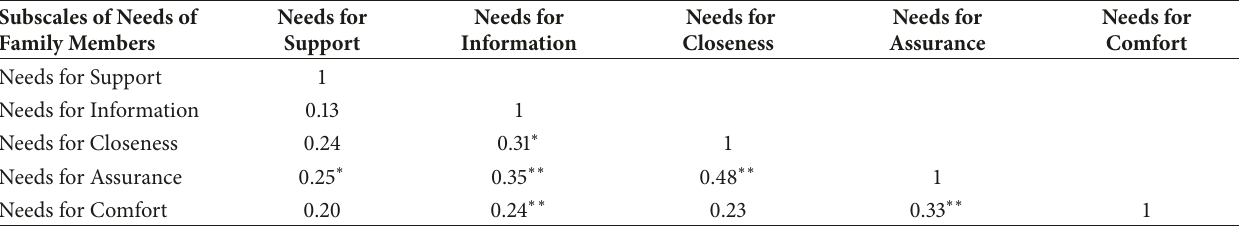
Table 8: Relationship between the subscales of needs of family